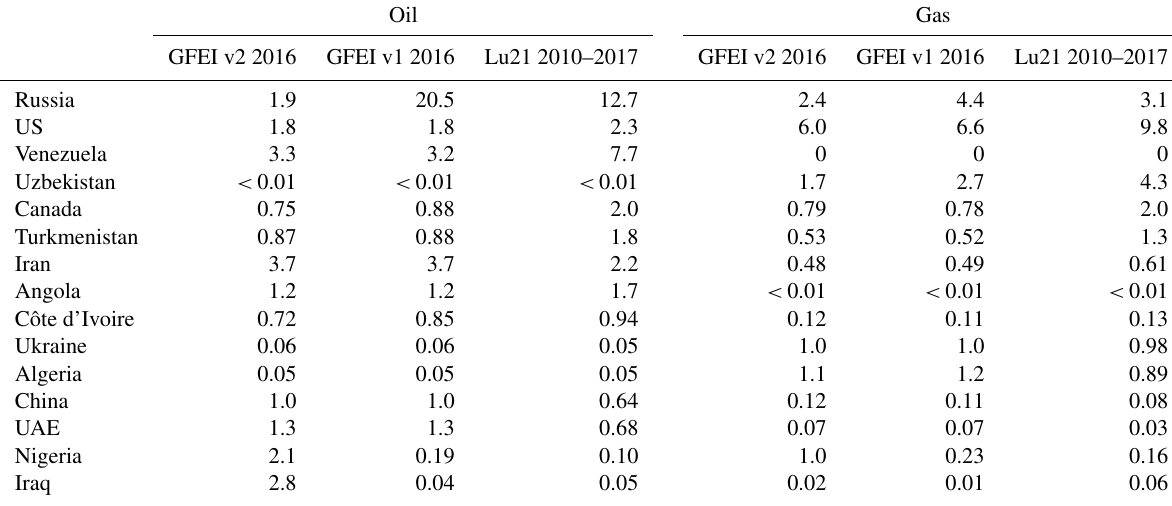
Table 2. Methane emissions from oil and gas activities by country (Tga − 1 ) ∗